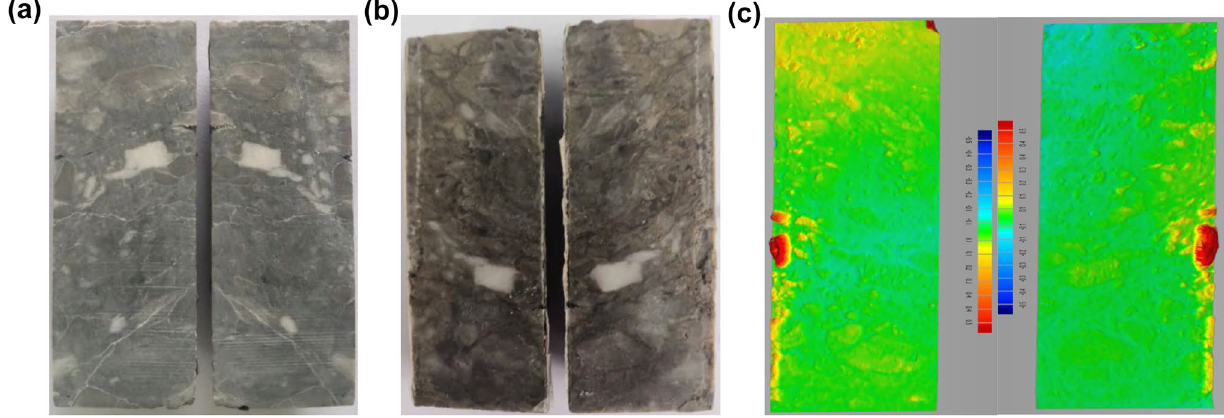
Fig. 7 Morphologies of gypsum-containing dolomite before ( a ) and after ( b ) corrosion with gelling acid and surface scanning image after corro- sion ( c